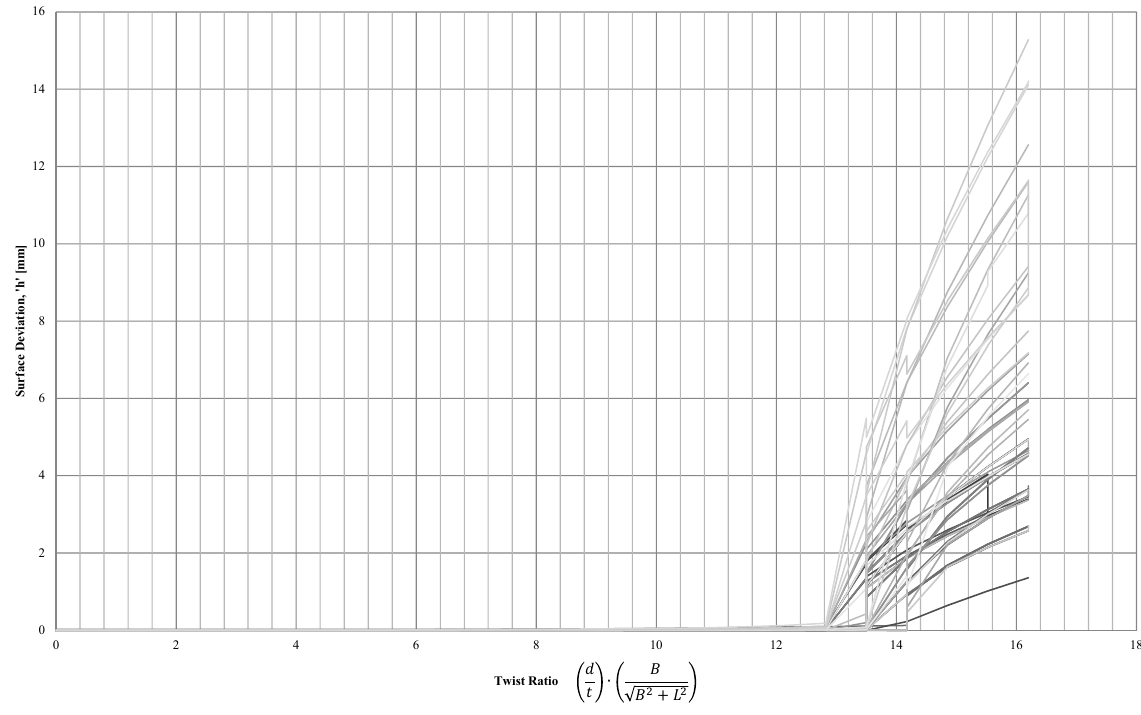
Fig. 9 Buckling Observations for all Finite Element